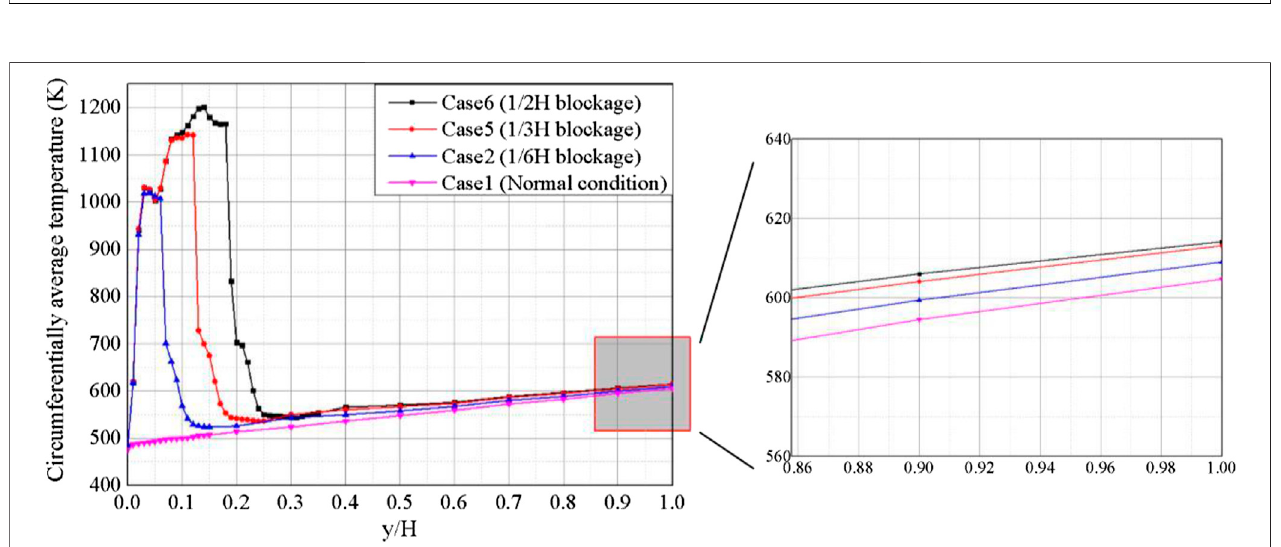
FIGURE 13 | The characteristics of the temperature evolution under a porous blockage with different porosities. (A) Circumferentially averaged temperature. (B) The maximum cladding temperature.